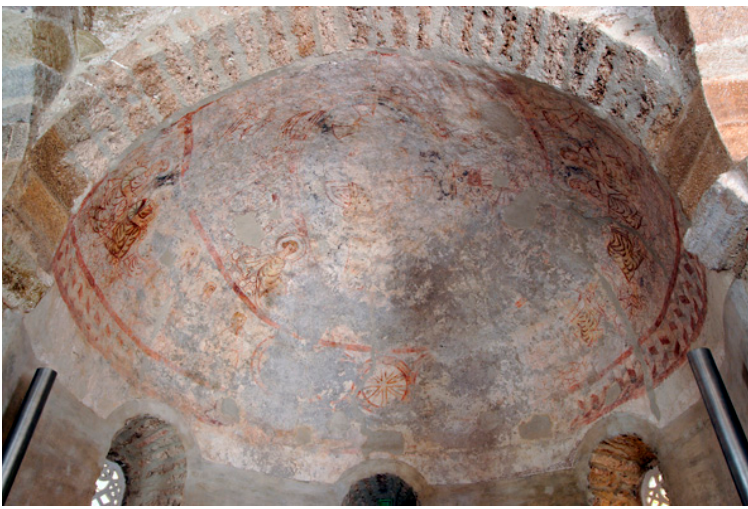
Figure 7. Sant Miquel de Terrassa, wall paintings of the apse. © author.